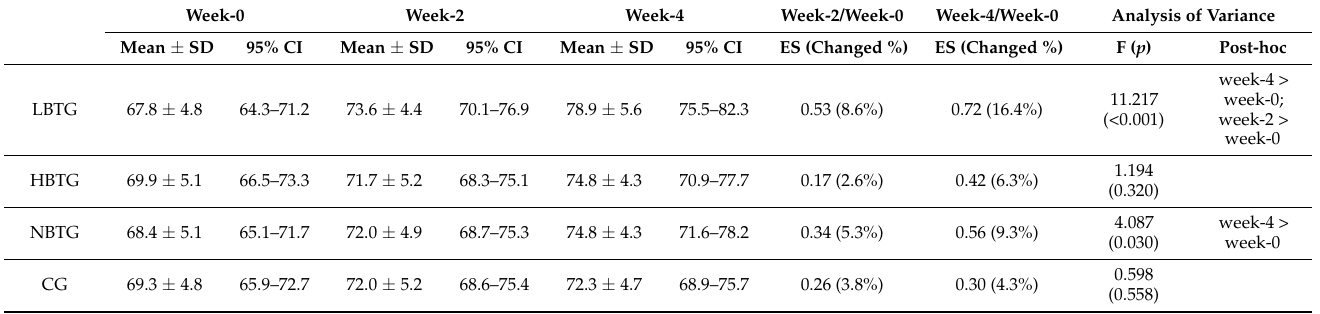
Table 2. Results of analysis of variance for repeated measures for training effect within the